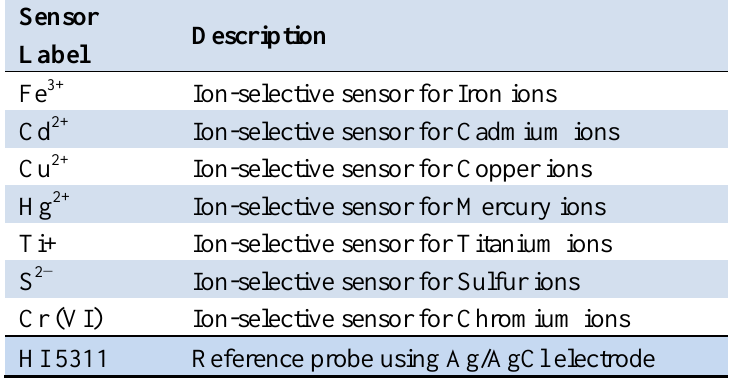
Table 2. Chalcogenide-based potentiometric electrodes used in